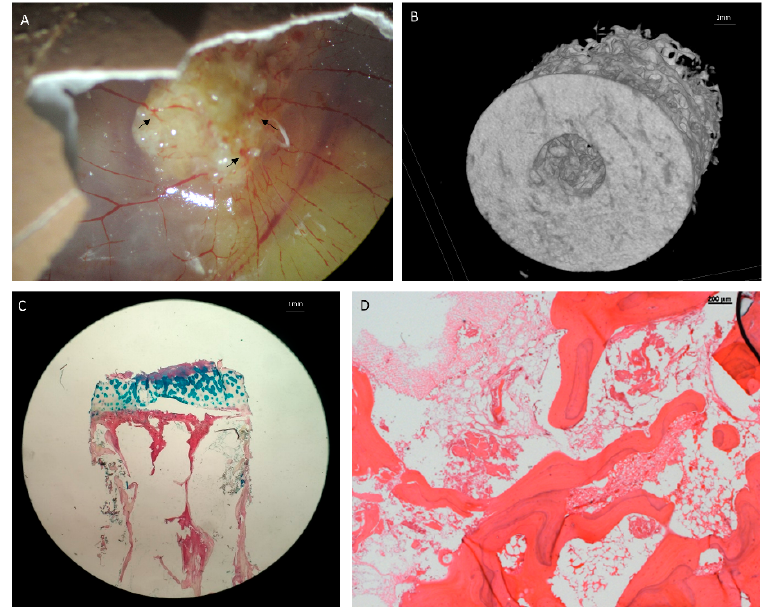
Figure 3. Bone extracellular matrix (ECM) implanted in CAM model for vascularization. ( A ) Human bone inserted into CAM model. Arrows show areas of angiogenesis into the bone. ( B ) A µ CT image of the bone model. ( C ) Alcian Blue and Sirius Red staining of the bone ECM, Blue denotes cartilage and proteoglycans, red denotes collagen. ( D ) Hematoxylin and Eosin Y staining of the bone ECM.